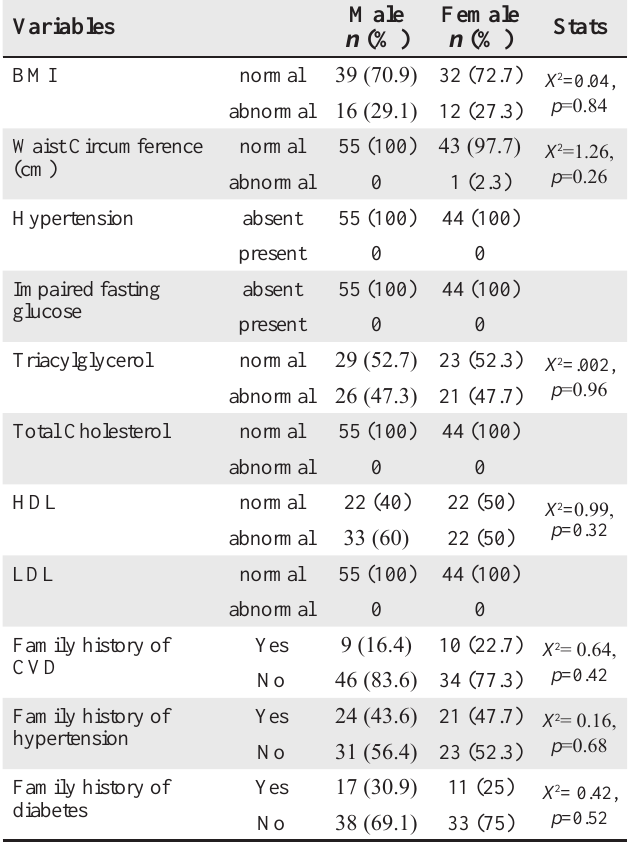
Table 1: Relationship between risk factors and gender (N =